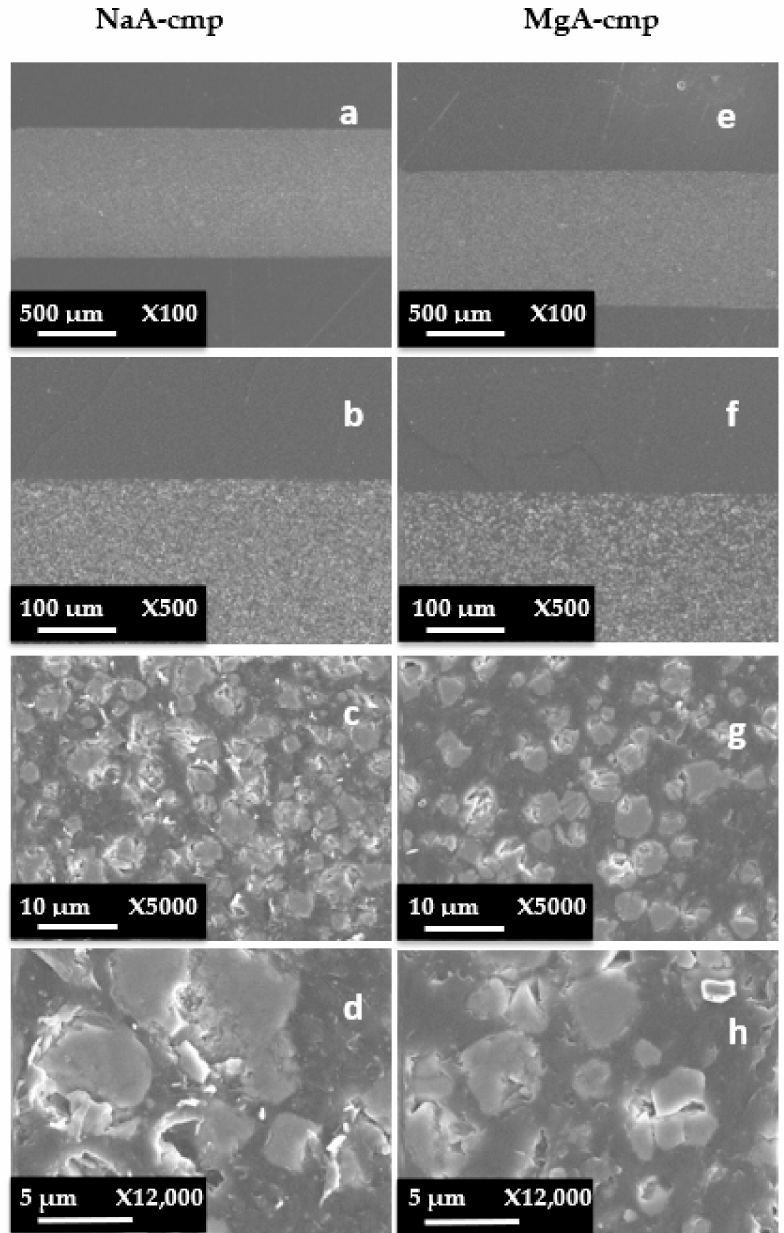
Figure A3. SEM images at different magnifications of molded part forms (side view) of ( a – d ) NaA- cmp and ( e – h ) MgA-cmp